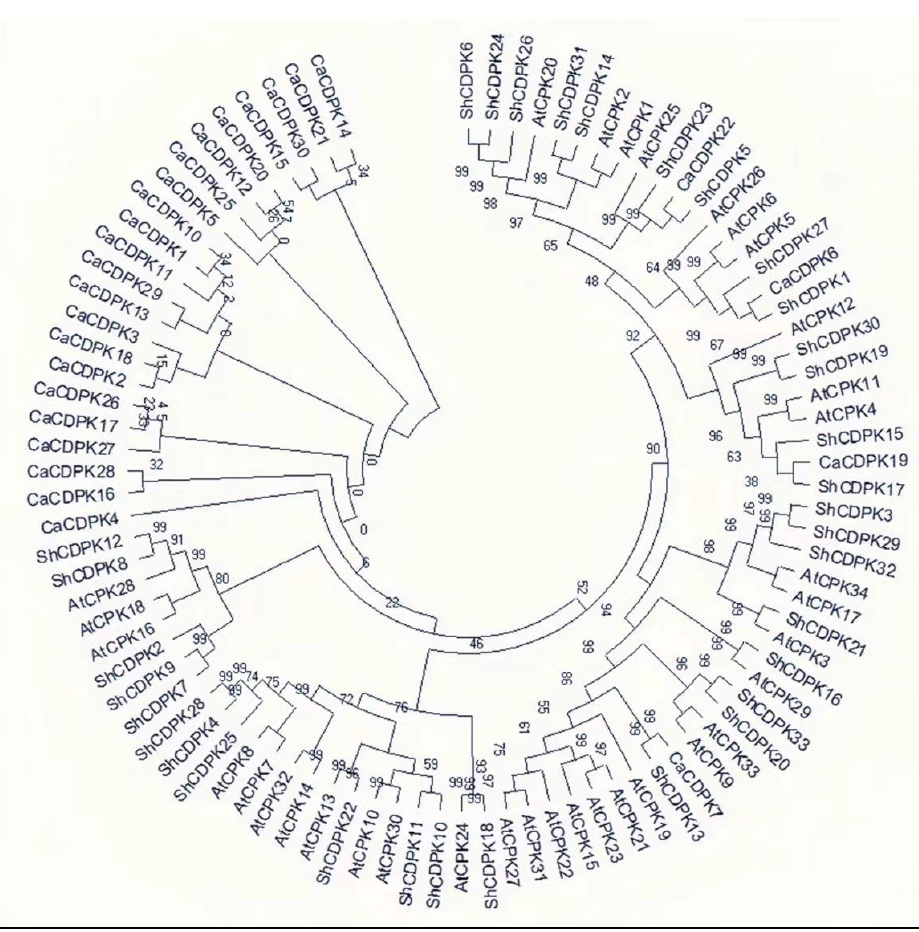
Figure 1. Phylogenetic tree analysis of CDPK gene family in Solanum habrochaites .